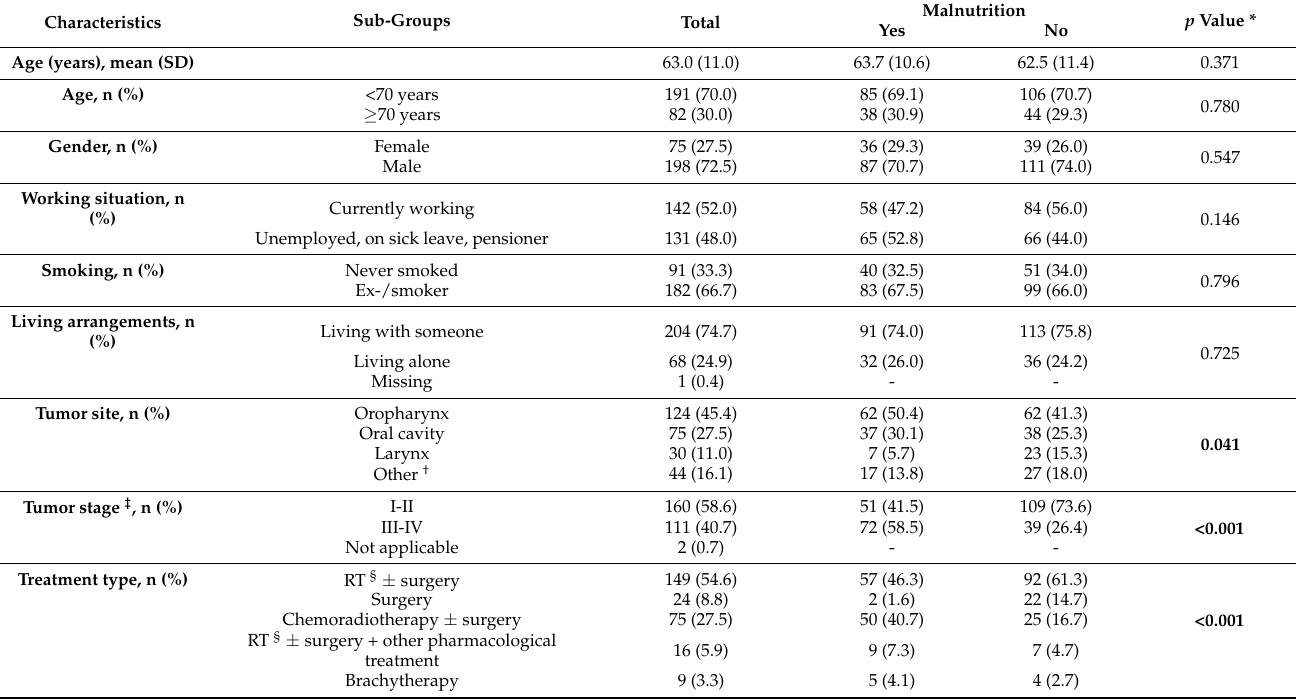
Table 1. Characteristics of the studied patients with head and neck cancer regarding the group in total ( n = 273), patients with malnutrition ( n = 123) at seven weeks after the start of treatment defined by the Global Leadership Initiative on Malnutrition (GLIM), and patients without malnutrition ( n =